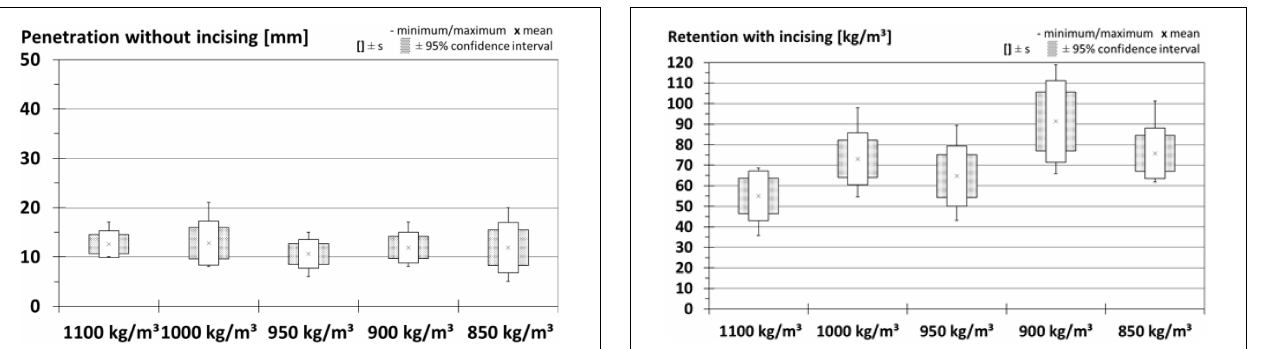
FIGURE 11 | Retention of an alternative oily preservative in kg/m 3 for specimen with incising.